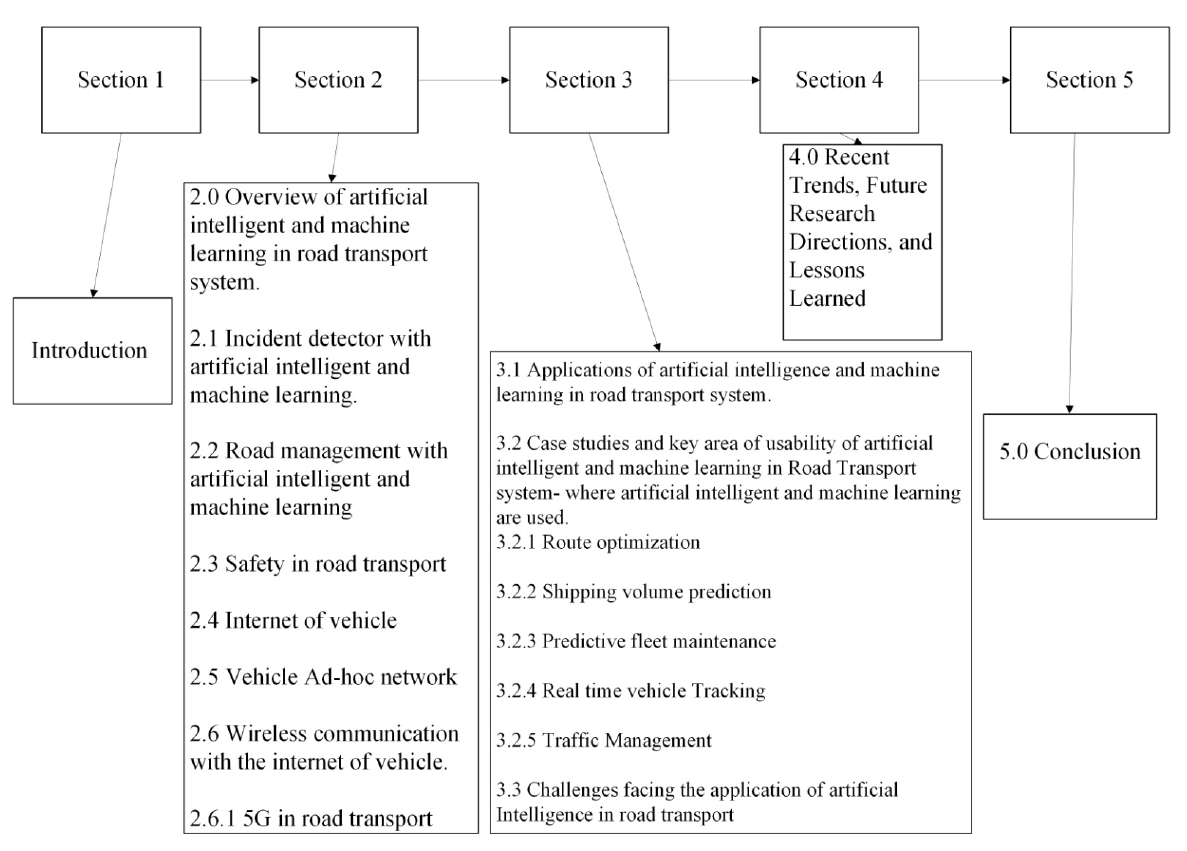
Figure 1. The layout of the review.